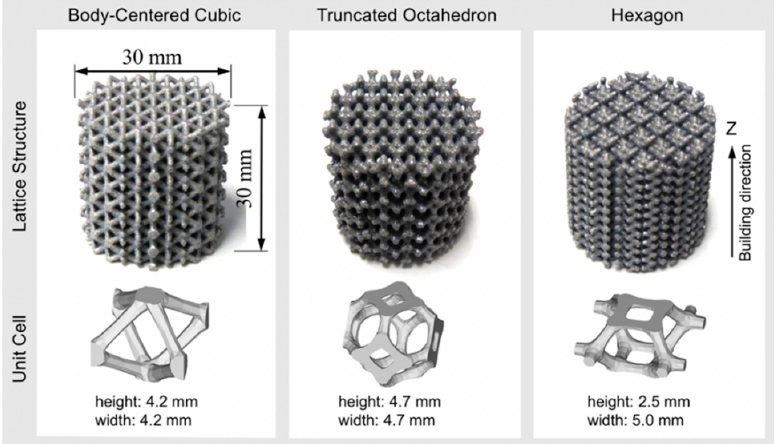
Figure 1. Photography images showing appearance of lattice structures and corresponding computer-aided design (CAD) models of body-centered cubic (BCC), truncated octahedron (TO), and hexagon (Hexa) unit cells.